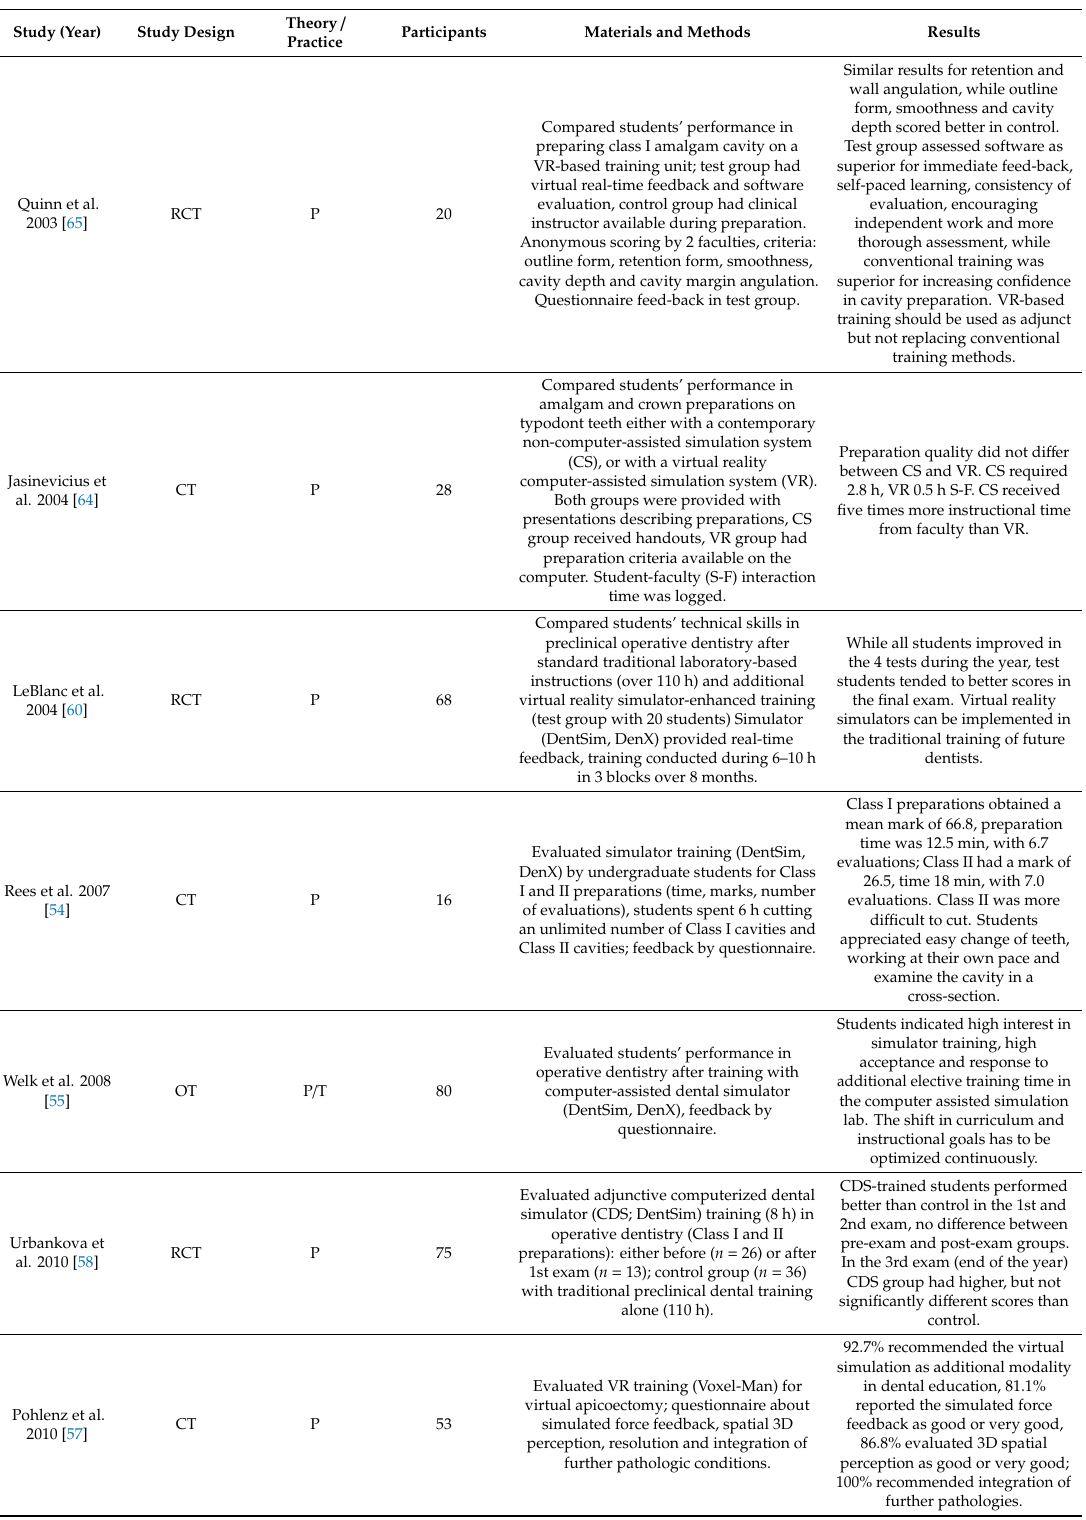
Table 3. Dental simulator motor skills incl. IOS ( n =